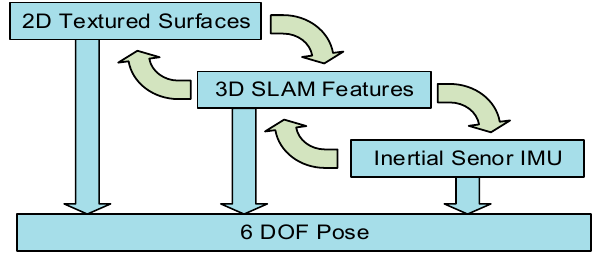
Figure 8. The waterfall model shows the combination of the different tracking methods.